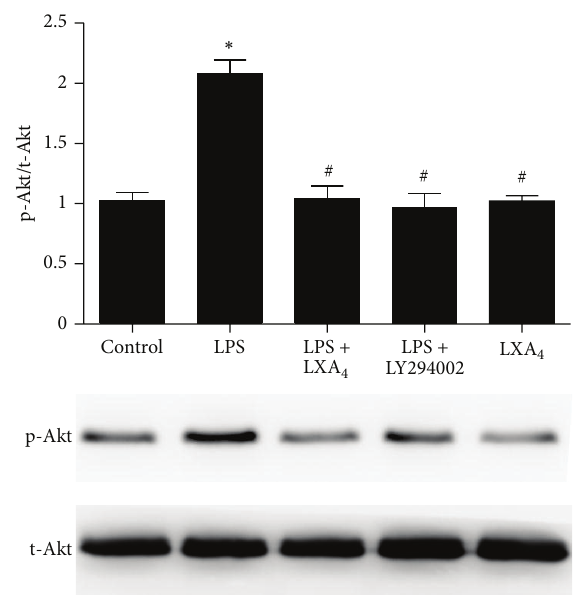
Figure 6: Lipoxin A 4 reverses LPS-induced phosphorylation of Akt. ATII cells were treated with LY294002 (10 𝜇 M, PI3K/Akt inhibitor) or lipoxin A 4 (100nM) in the presence of LPS (1 𝜇 g/mL) for 30min. After incubation, the cells were harvested and sonicated. Phosphorylation of Akt in the cell lysates was assessed by western blotting. Data were expressed as mean ± SEM for each group. ∗ 𝑃 < 0.05 versus control group, # 𝑃 < 0.05 versus LPS group, 𝑛 = 4 for each group. LPS = lipopolysaccharide, LXA 4 = lipoxin A 4 .